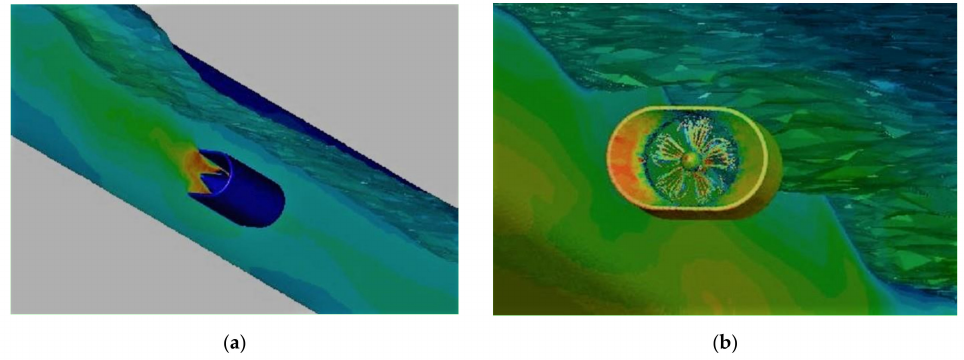
Figure 5. Example of the 3D CFD outputs. ( a ) Flow velocities on free surface and in vertical middle plane; ( b ) dynamic pressures on propulsor and on walls of the